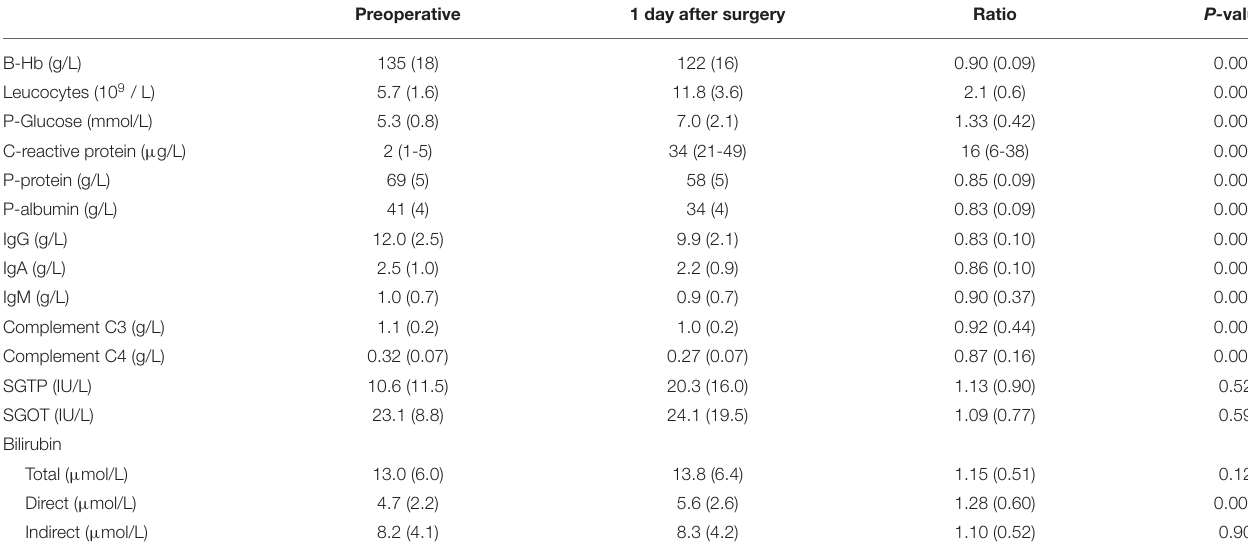
TABLE 3 | Biochemical measurements on whole blood or plasma in 126 patients undergoing surgery for colorectal cancer.